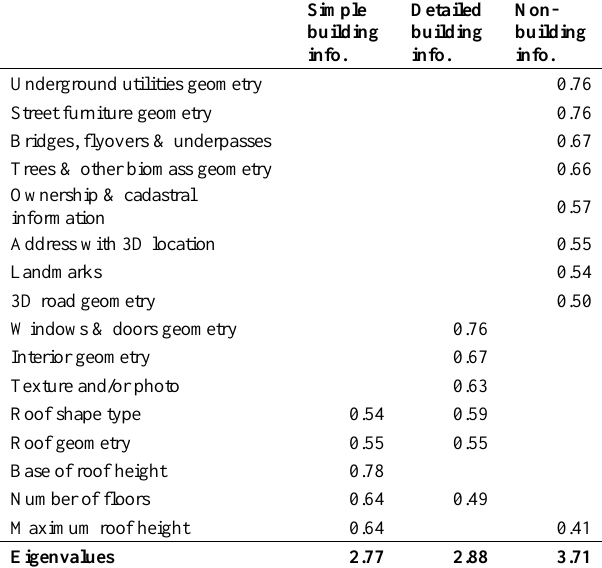
Table 5. Truncated summary table of the EFA.